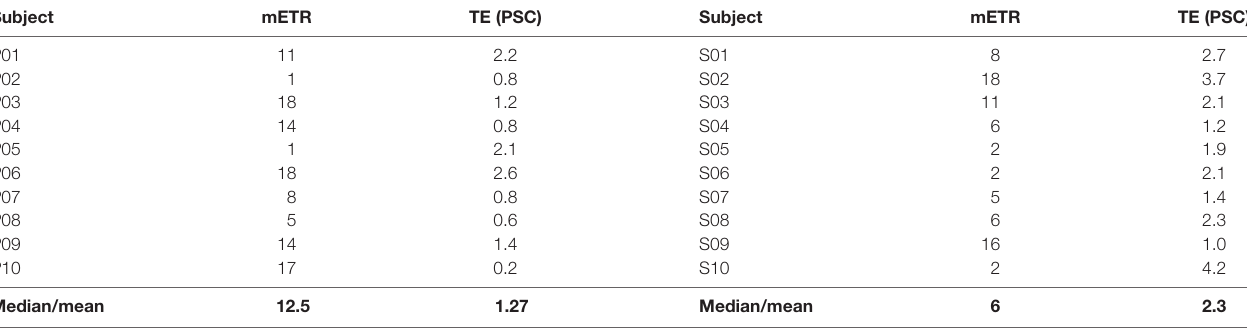
TABLE 1 | The run number, i.e., position, of the most efficient training run (mETR) within the 18 training runs and its corresponding training efficiency (TE) in percent signal change (PSC), i.e., PSC aMCC minus PSC bg for each subject as well as their central tendency (median for mETR and mean for TE) in one of the two feedback